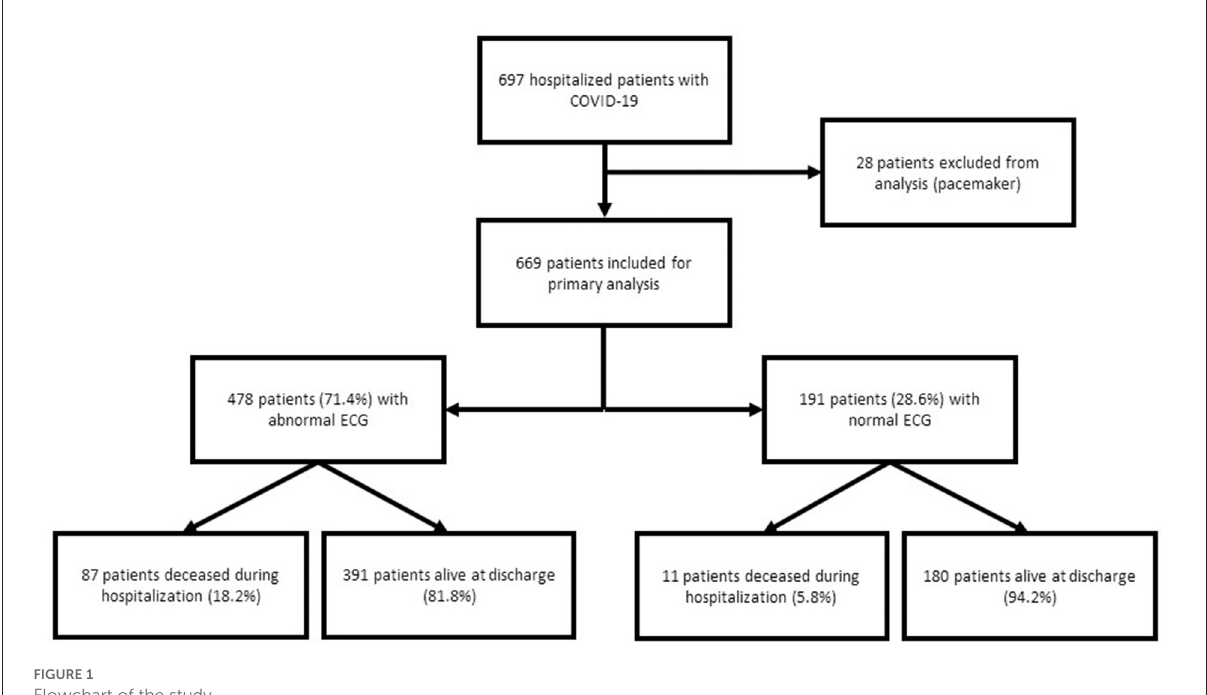
FIGURE1 Flowchart of the study.